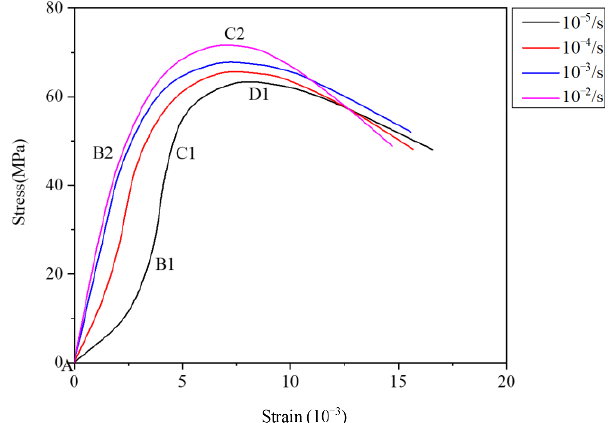
Figure 12. Stress–strain curve of SF10 specimens with 100 F–T cycles and 5 MPa confining pressure Figure 12. Stress – strain curve of SF10 specimens with 100 F – T cycles and 5MPa confining pressure under different strain rates. under different strain rates.